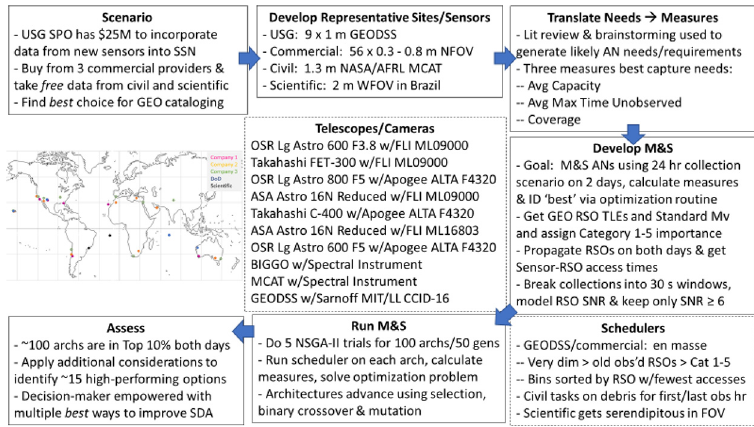
Figure 2. Methodology